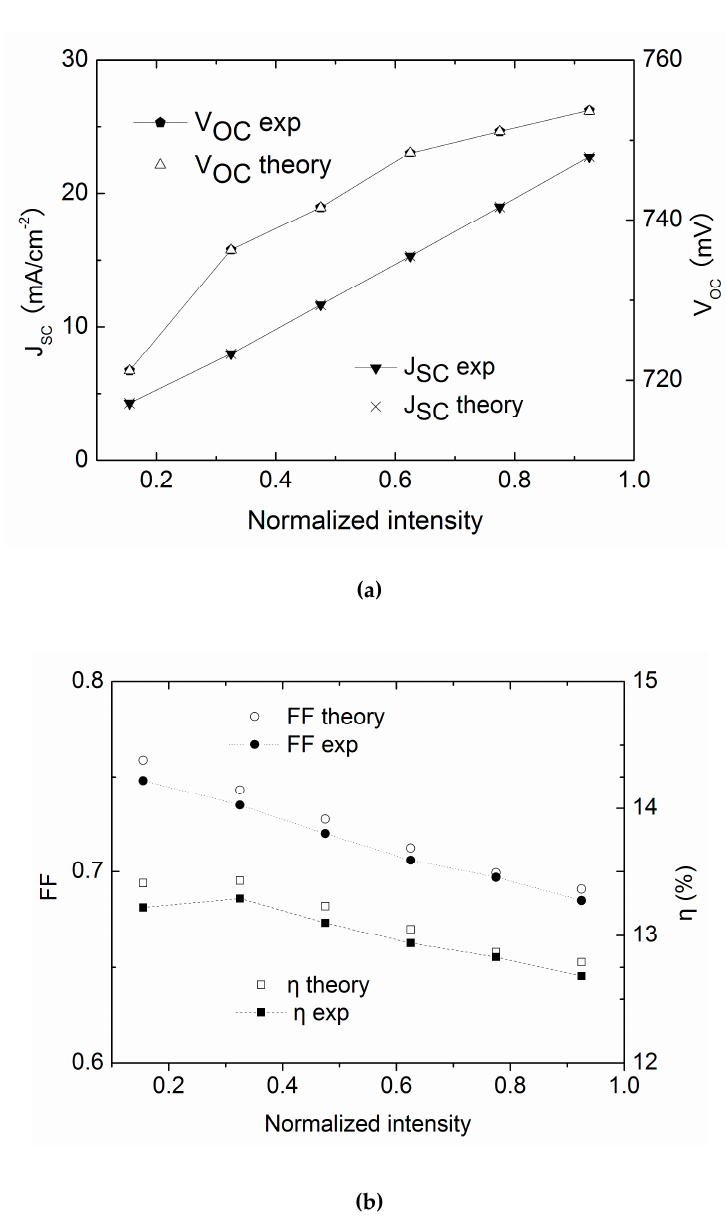
Figure 10. Comparison of theory and experimental values for the CdTe solar cell #2, ( a ). Jsc and Voc; ( b ) FF and η